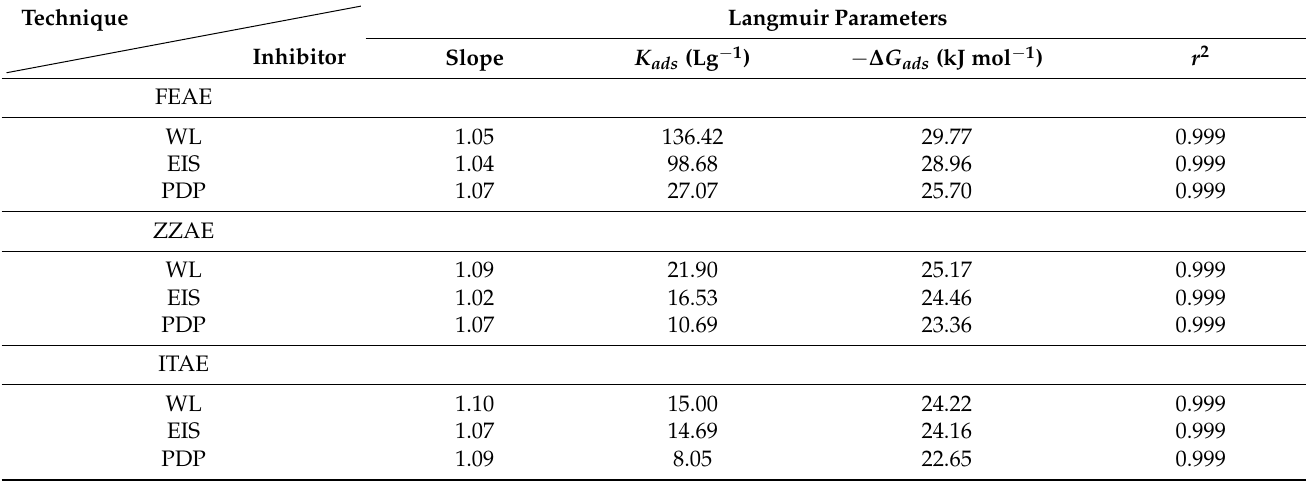
Table 6. Langmuir’s adsorption parameters for the studied plant extracts from 2 M H 3 PO 4 on mild